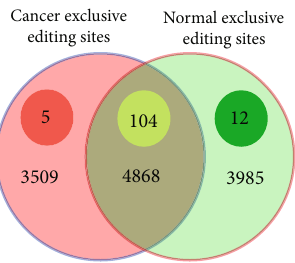
Figure 11: Number of editing sites in cancer and normal tissues. Inner circles indicate the number of di ff erentially edited sites between two groups ( P value < 0.05).